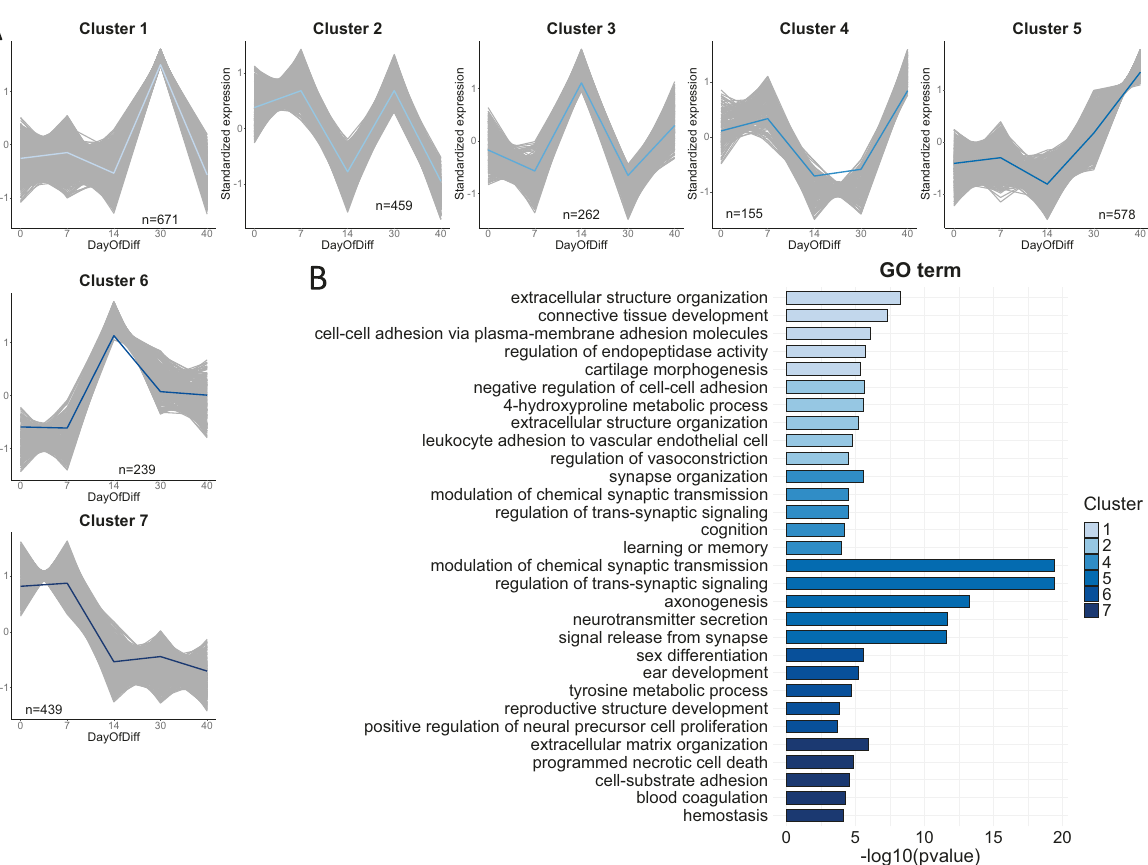
Fig. 4 Differentiation-associated gene clusters highlight biological functions important for astroglial differentiation. A DE genes involved in astrocyte differentiation form seven distinct clusters with shared expression trajectories. Only DE genes with cluster membership >0.5 are visualized. The number of genes in each cluster is indicated. The blue-colored lines represent cluster centroids (mean gene expression). B Top signi fi cant functional annotations (biological processes) and corresponding − log10( p -value) are shown for each gene cluster. Cluster colors correspond to the centroid colors in ( A ). Cluster annotations are based on DE genes with membership >0.5. Cluster 3 was not signi fi cantly enriched for any GO term. GO Gene